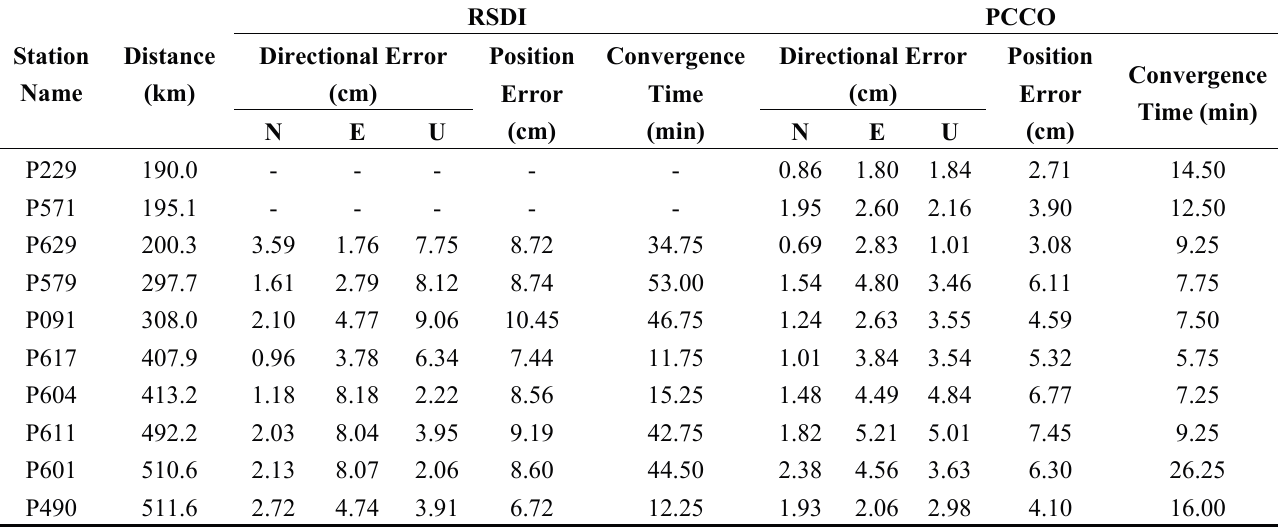
( e ) Figure 9. Results of stations outside the network: ( a ) N; ( b ) E; ( c ) U; ( d ) convergence time; ( e ) position error. Table 2. RMS of the positioning error and convergence time of RSDI and